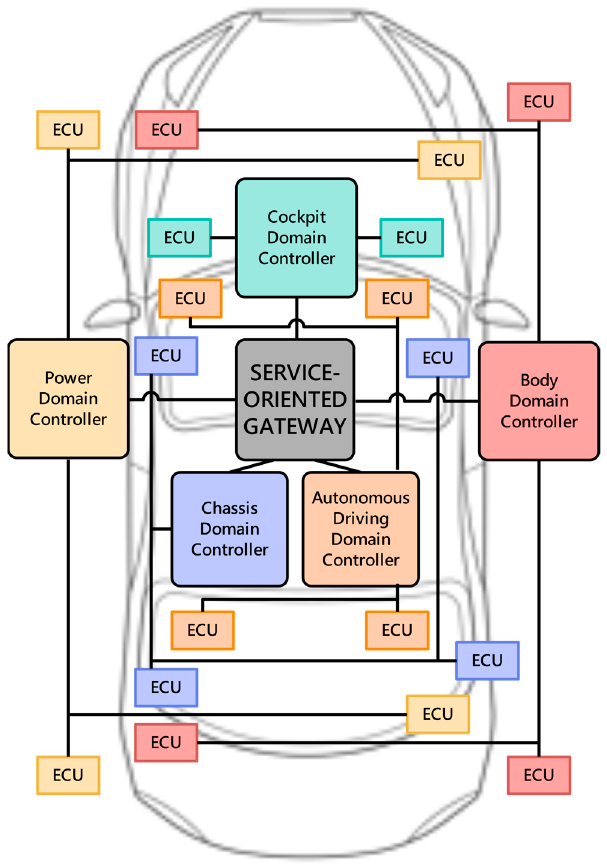
Figure 1. Body structure of domain IVN architecture. The network is divided into five areas by function: power domain, chassis domain, cockpit domain, autonomous driving domain and body domain.